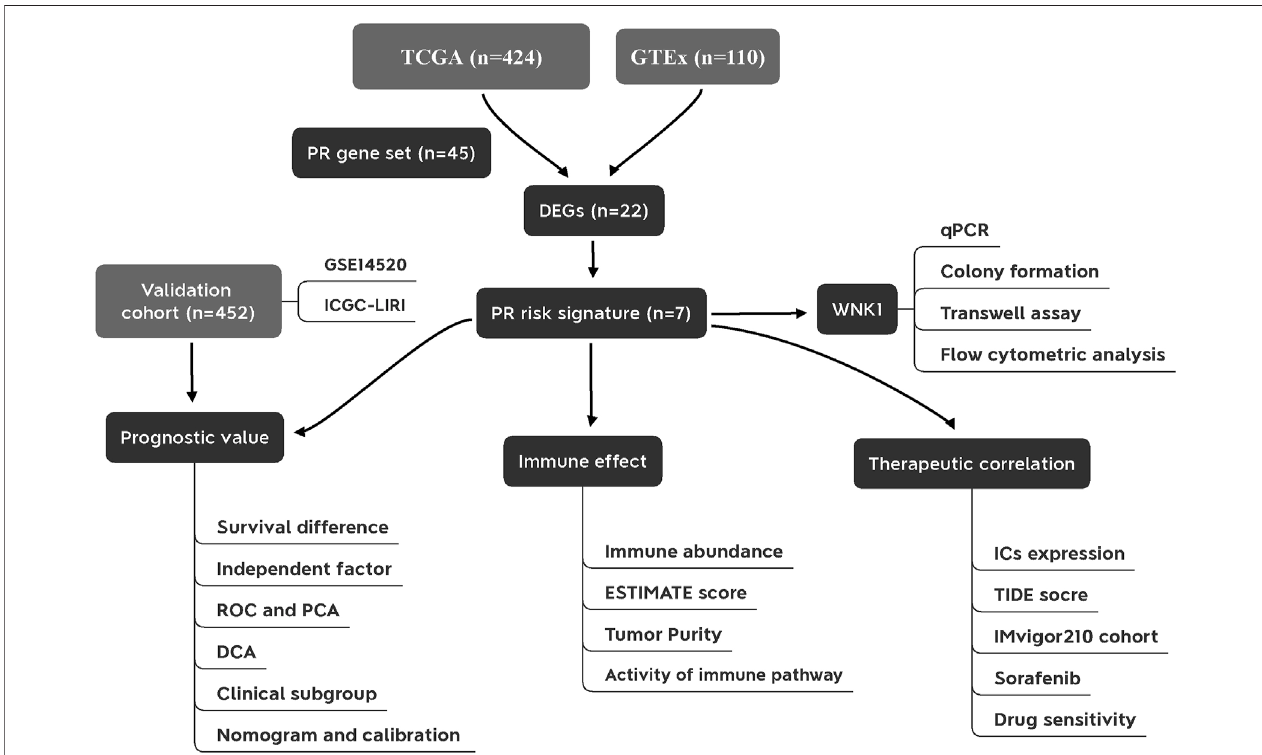
FIGURE 1 | Flowchart of the present study. PR, pyroptosis-related; DEGs, differentially expressed genes; ROC, receiver operating characteristic curve; PCA, principal component analysis; DCA, decision curve analysis; ICs, immune checkpoints.